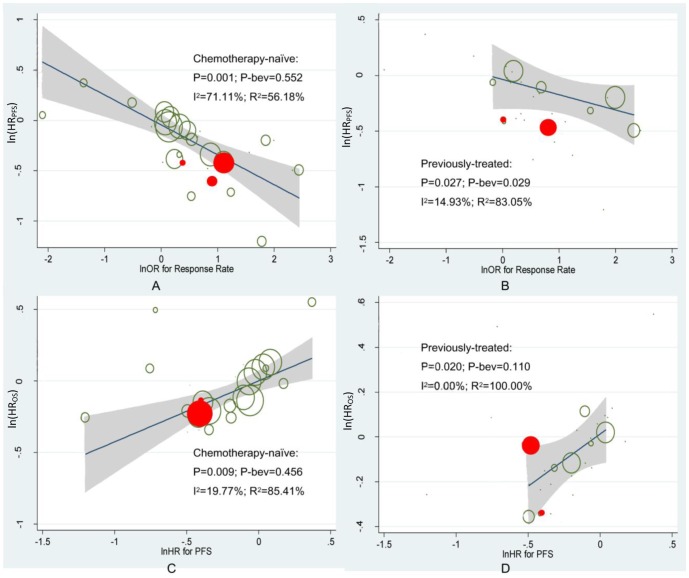
Results of meta-regression.A: ln(HRPFS) – ln(ORORR), in chemotherapy-naïve patients; B: ln(HRPFS) – ln(ORORR), in previously-treated patients; C: ln(HROS) – ln(HRPFS), in chemotherapy-naïve patients; D: ln(HROS) – ln(HRPFS), in previously-treated patients.